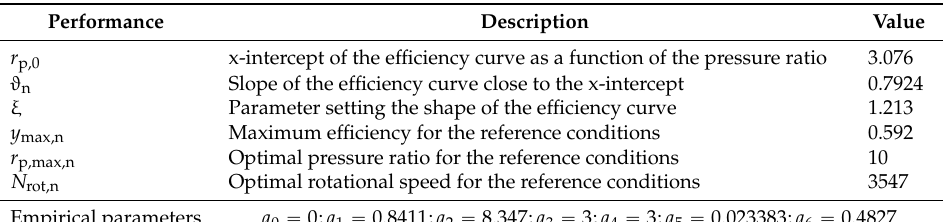
Table 1. Parameters for efficiency model of